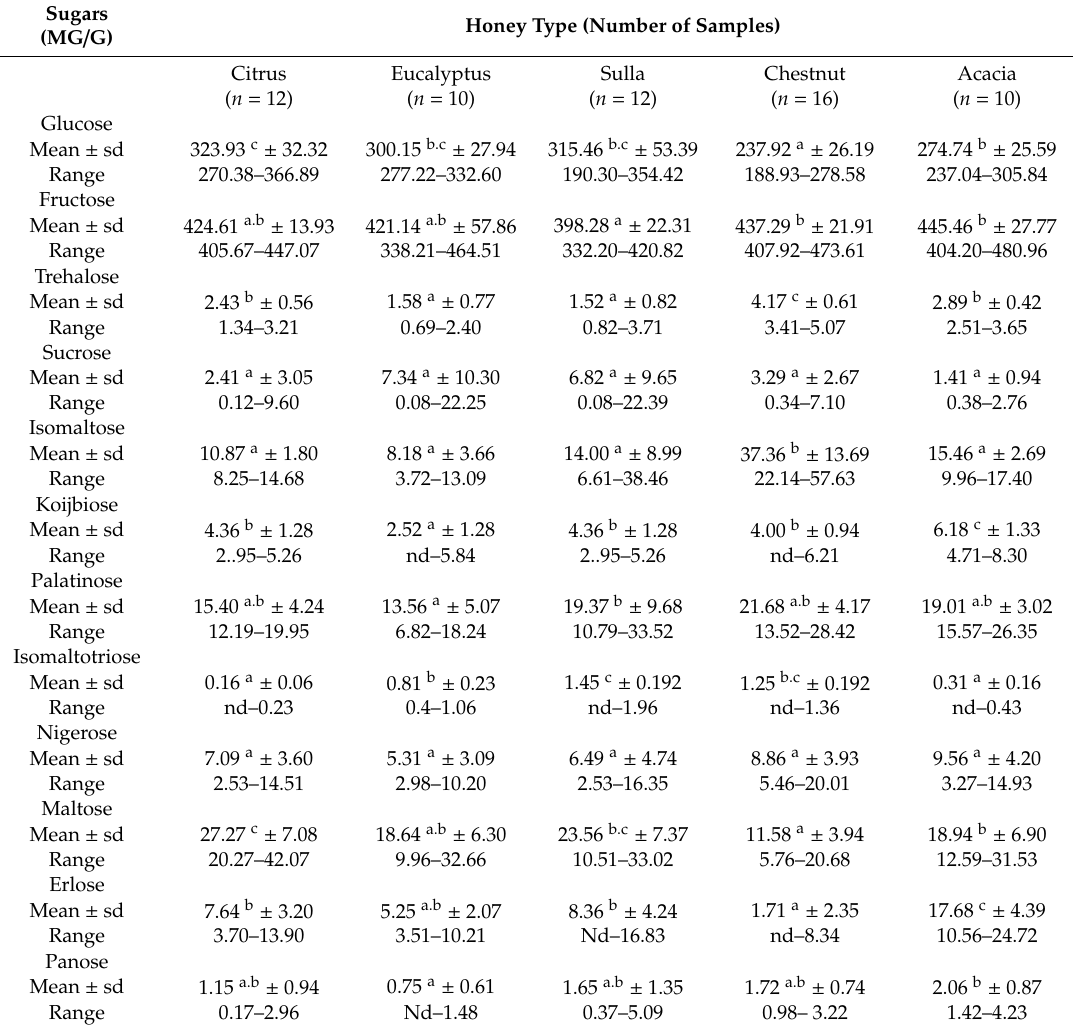
Table 2. Sugars profile in the di ff erent honeys of